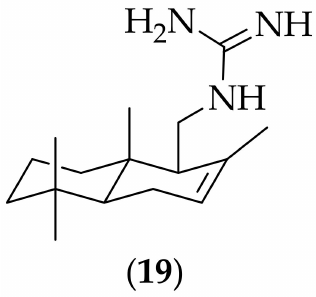
Figure 10. Drimenol-derived antifungal compound ( 19